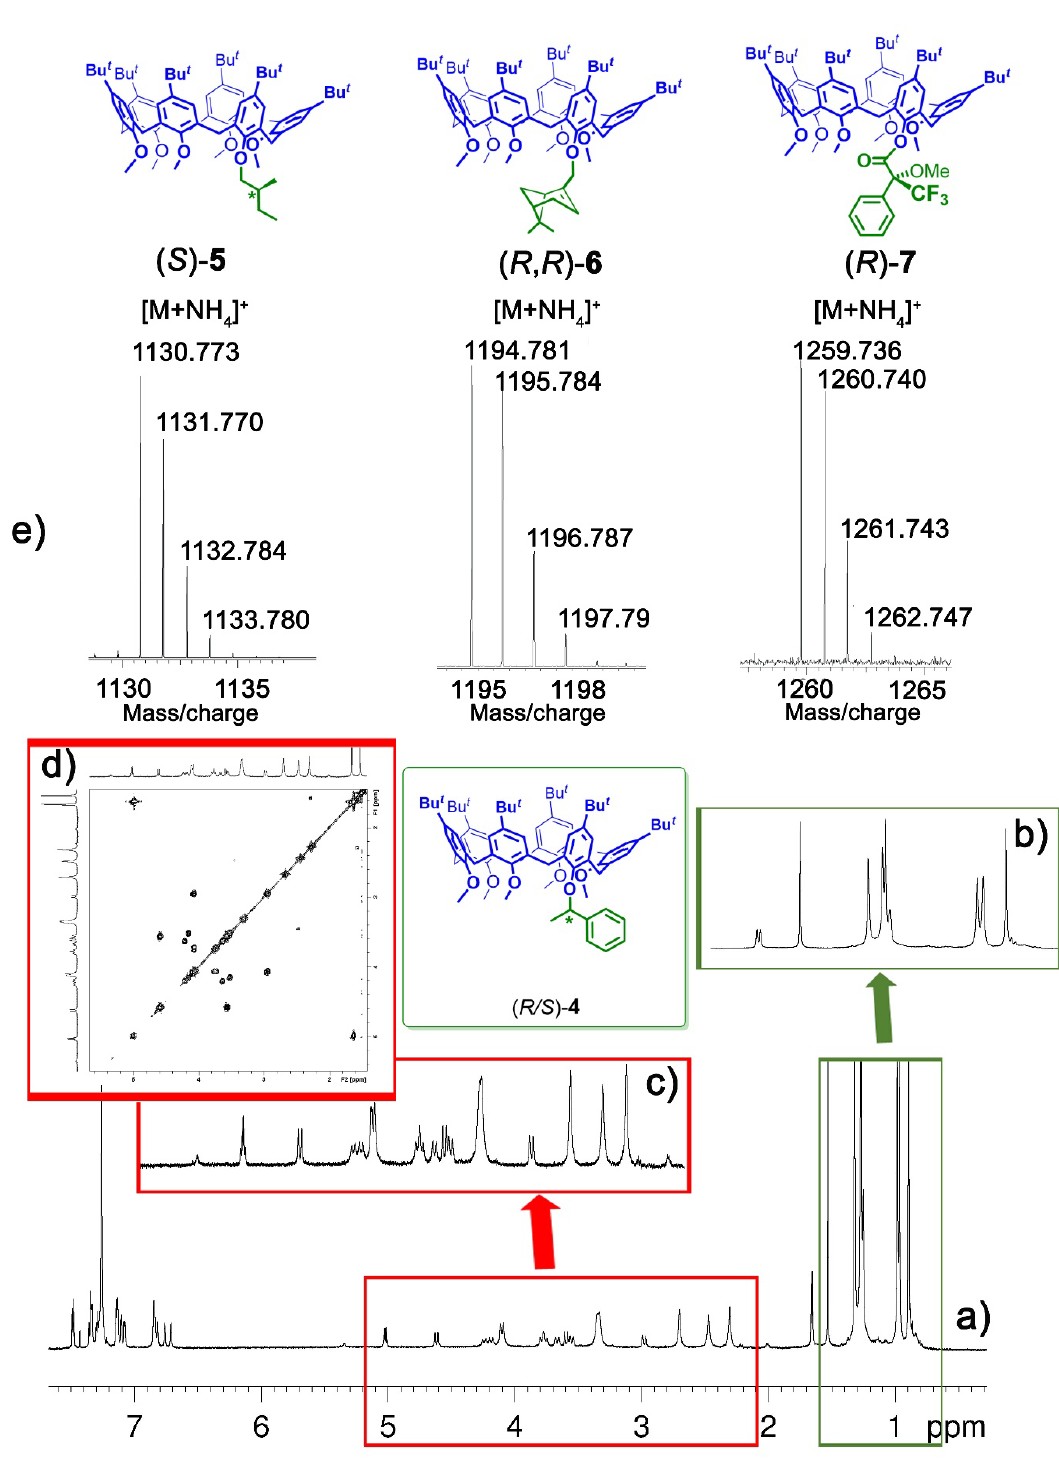
Figure 2. 1 H NMR spectrum (CDCl 3 , 600 MHz) of derivative ( R/S )- 4 at 298 K ( a ). Different portions of its 1 H NMR ( b , c ) and COSY−45 ( d ) spectrum. Partial ESI mass spectra of compounds ( S )- 5 , ( R , R )- 6 , and ( R )- 7 ( e ).